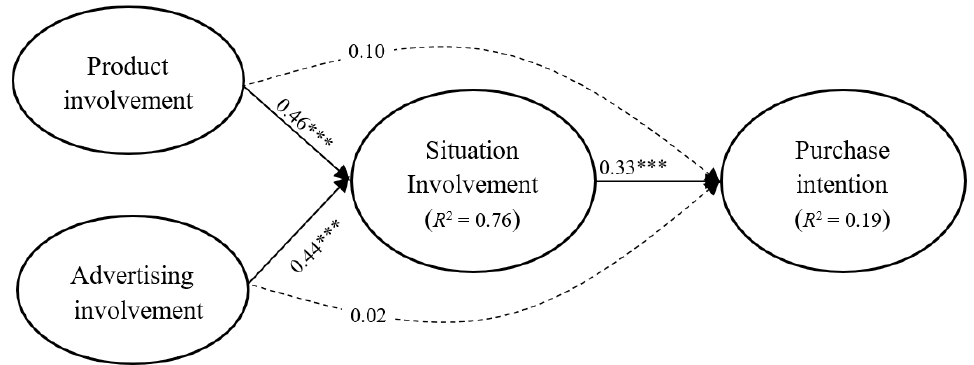
Figure 2. Mediation model for the relationship between involvement types and purchase intention ( n = 1046) *** p < 0.001. ( n = 1046) *** p <